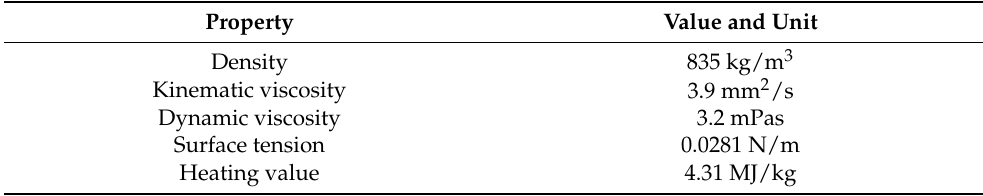
Table 2. Properties of diesel fuel ued in spray simulation [13].